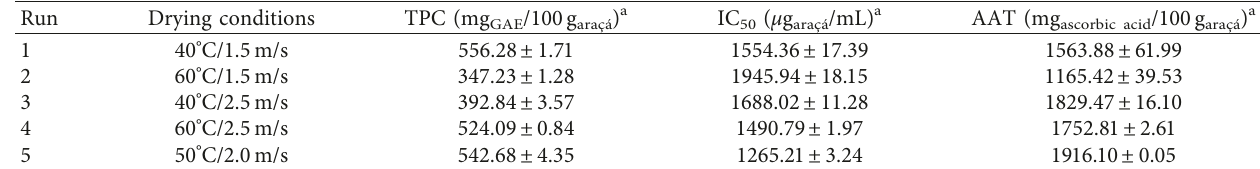
Table 3: Antioxidant capacity of extracts obtained from araç´a dried under different